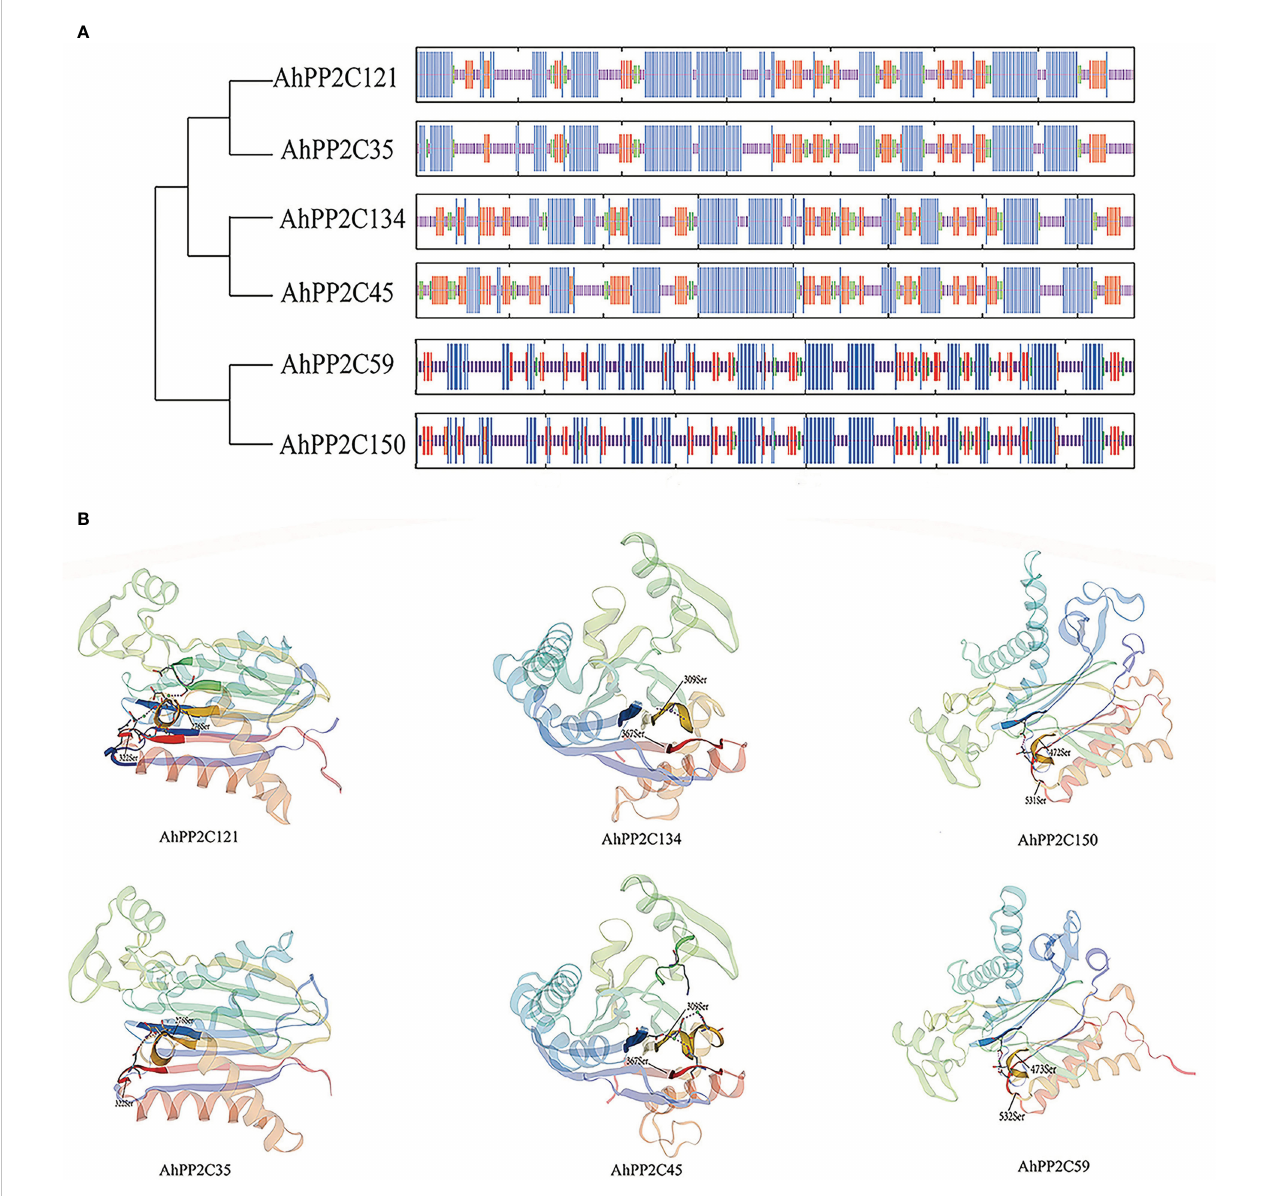
FIGURE 7 Protein structures and catalytic site prediction of AhPP2C s in subclades AI and AII. (A) protein secondary structures of AhPP2C s. a -helices were in blue; irregular curls were in purple; b -sheets were in red; b -turns were in green. (B) protein tertiary structures and catalytic sites of AhPP2C s in subclades AI and